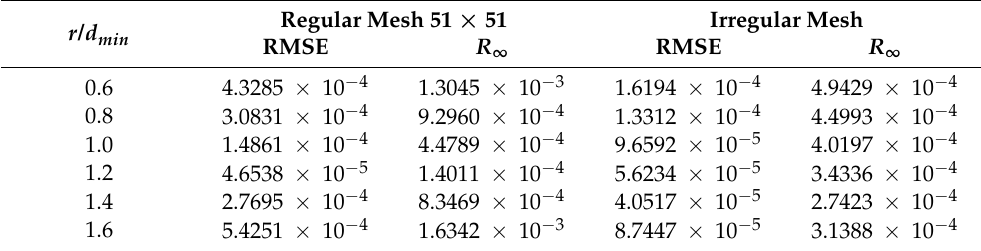
Table 4. Example No. 1—comparison of RMSE and R ∞ for different radius of the virtual area.